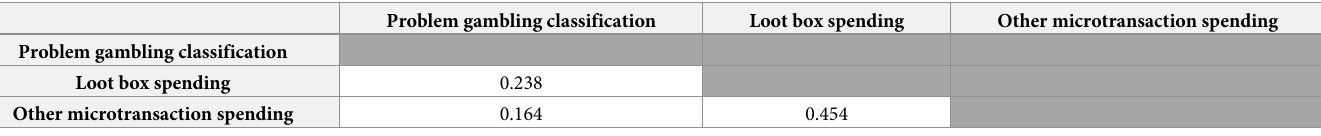
Table 6. Correlation matrix for Spearman rank correlations between raw problem gambling scores, loot box spending, and other microtransaction